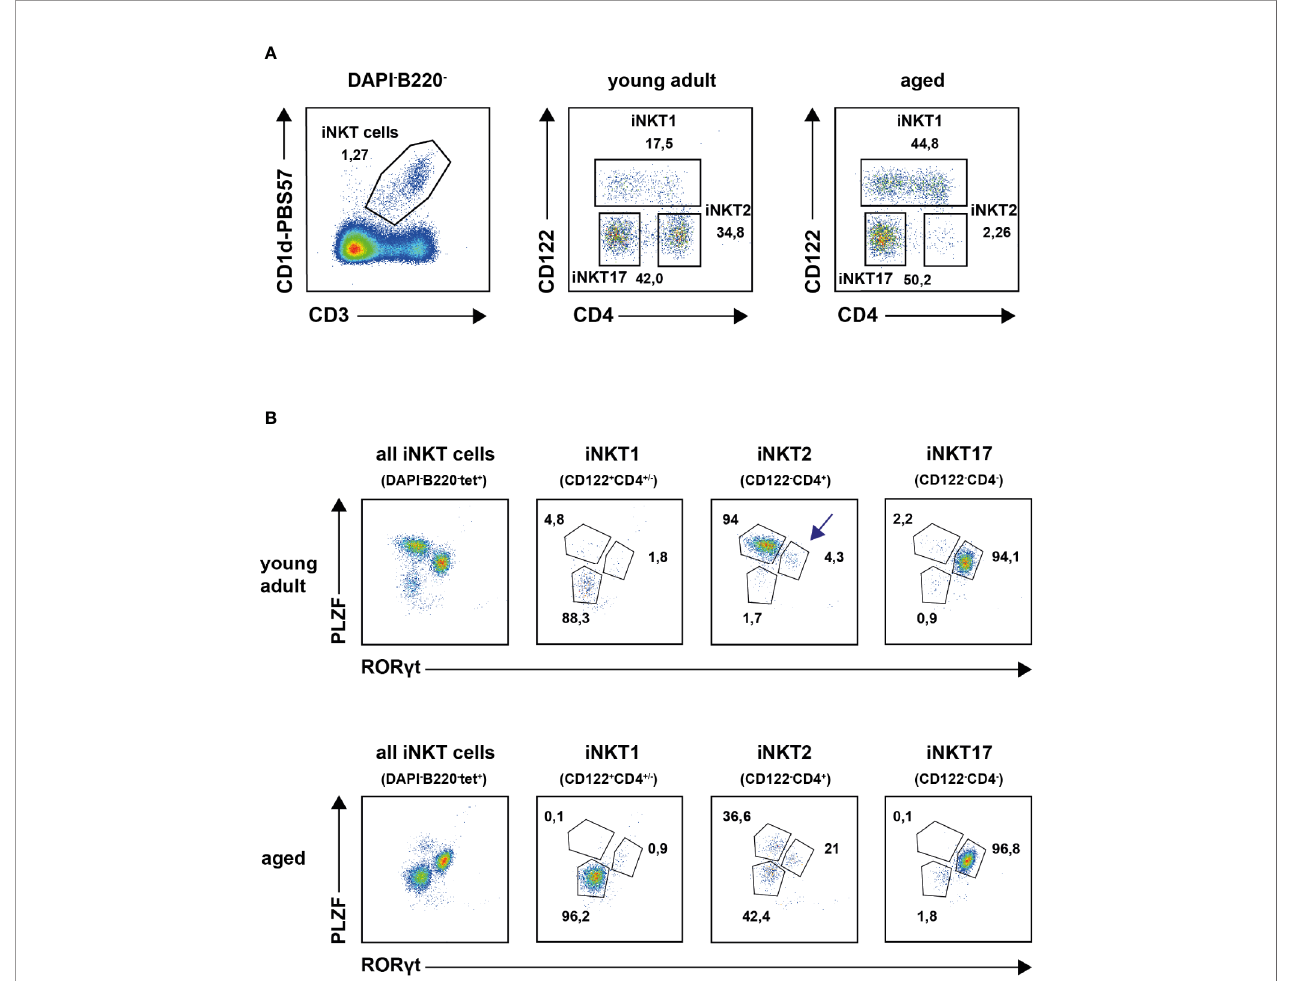
FIGURE 1 | Thymic invariant natural killer T (iNKT) subsets in young adults and aged mice. (A) Representative plots illustrating thymic iNKT subset composition in young adult and aged BALB/c mice following application of the indicated gates. (B) Representative plot showing transcription factor staining of tet + thymic iNKT cells (left panels) and of iNKT subsets as de fi ned by surface markers CD122 and CD4 from young adult (upper panel) or aged (lower panel) BALB/c mice. Average frequencies are given for cells in the indicated gates derived from analysis of four young adult and fi ve aged